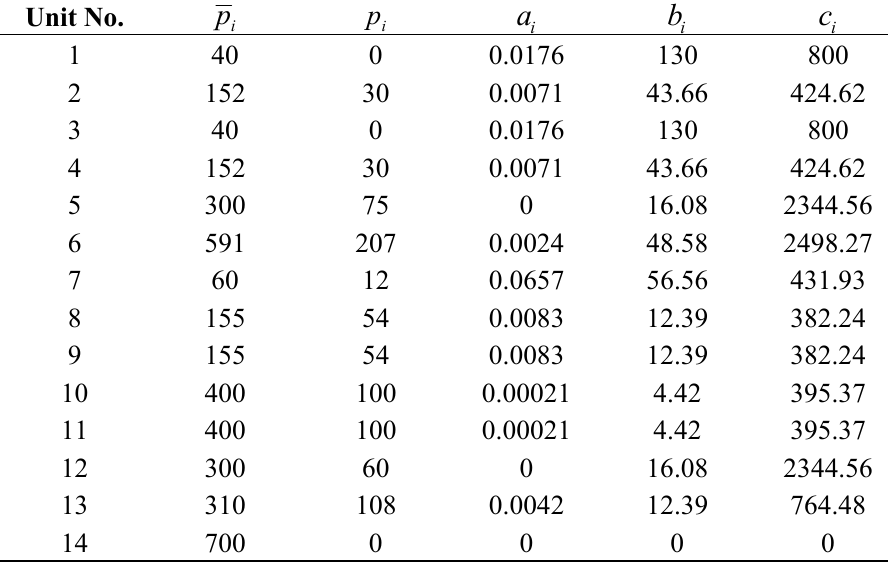
Table A1. Unit parameters of the IEEE RTS